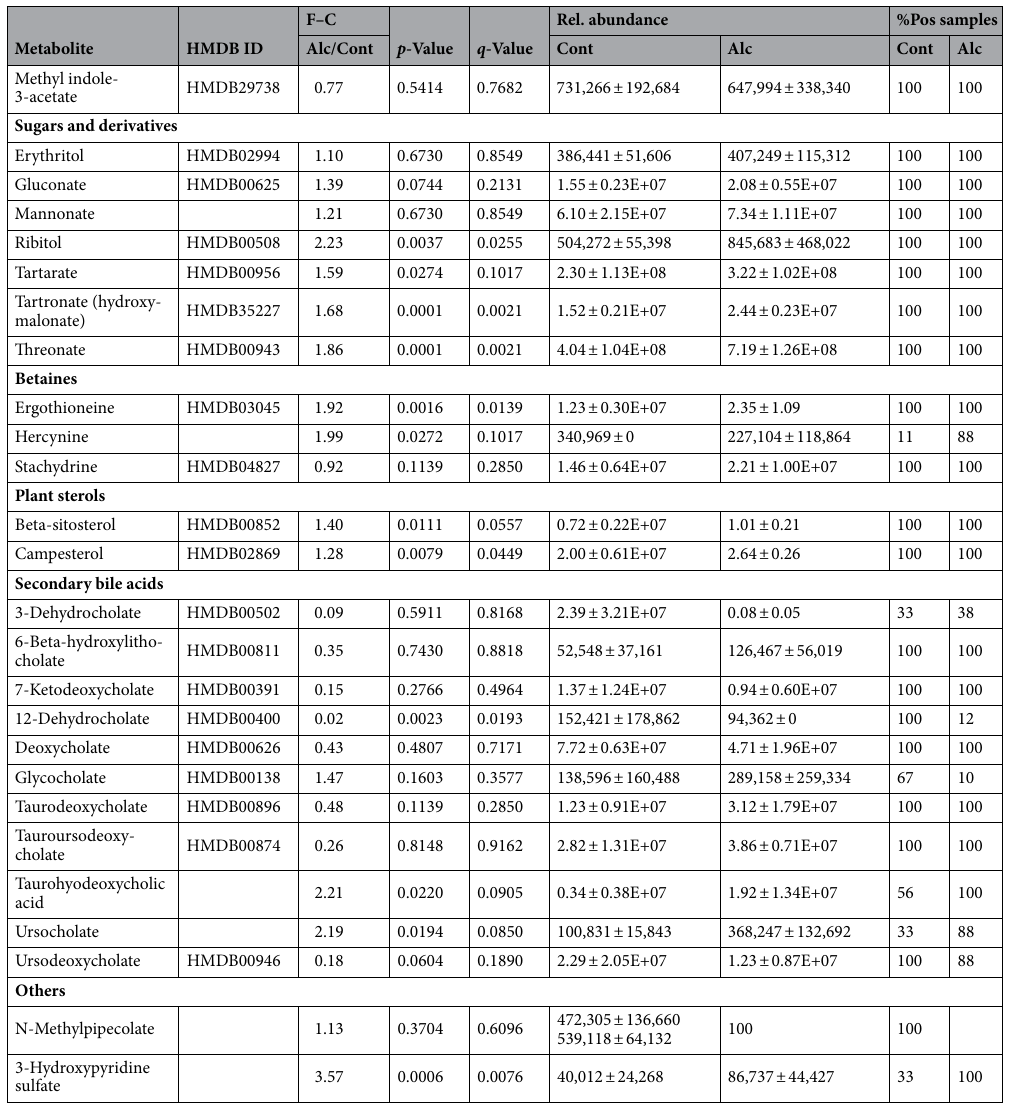
Table 1. Microbial-derived products detected in maternal plasma. N = 9 control and N-8 alcohol-exposed dams; p -value by Mann–Whitney U-test; q -value by Benjamini–Hochberg FDR correction.